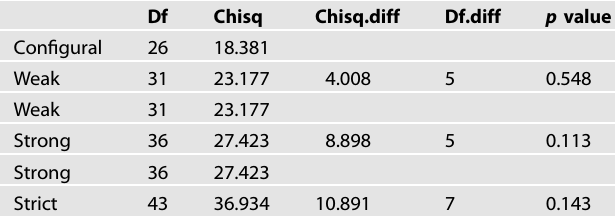
Table 3. CFA results of reduced PSS-10 questionnaire con fi rmed that the reduced two factor model of PS is invariant between